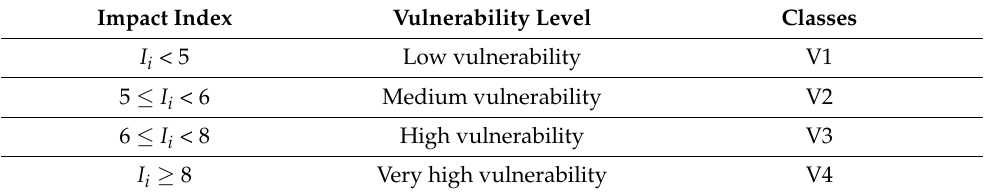
Table 2. Morphological vulnerability